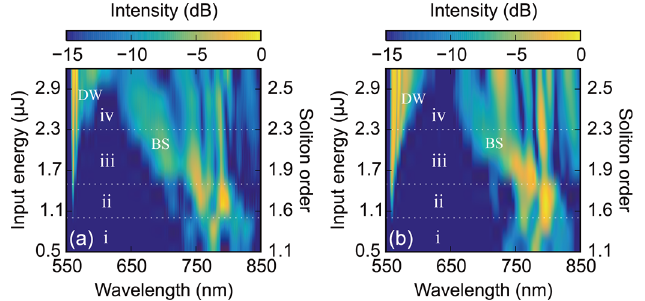
Figure 3. Plotted using the open source software Python(x,y). Measured ( a ) and simulated ( b ) spectral evolutions after propagating a 25-cm-long SR HC-PCF with 24- µ m core diameter and 1.4-bar Ar as a function of input pulse energy. In both ( a , b ), DW = dispersive wave, BS = blueshifting soliton. At low pulse energy levels (from 0.5 µ J to 1 µ J), the pulses undergo the SC process due to the combined effects of SPM and waveguide-induced anomalous dispersion. As shown in Figure 4a,b, we plot the simulated temporal and spectral evolutions in a 25-cm-long Ar- filled SR HC-PCF at input energy of 0.5 µ J. As the propagation distance increases, the peak power of the self-compressed pulses increases rapidly, resulting in a rapid accumulation of plasma [marked as the white circle lines in Figure 4b] due to gas ionization. In Figure 4c, we can see that the simulated spectrum (red solid line) at the fiber output is in good agreement with the experimental spectrum (green shaded region). At certain pulse energy levels (from 1 µ J to 1.5 µ J), the SC process leads to a wider pulse spectrum, which results in the